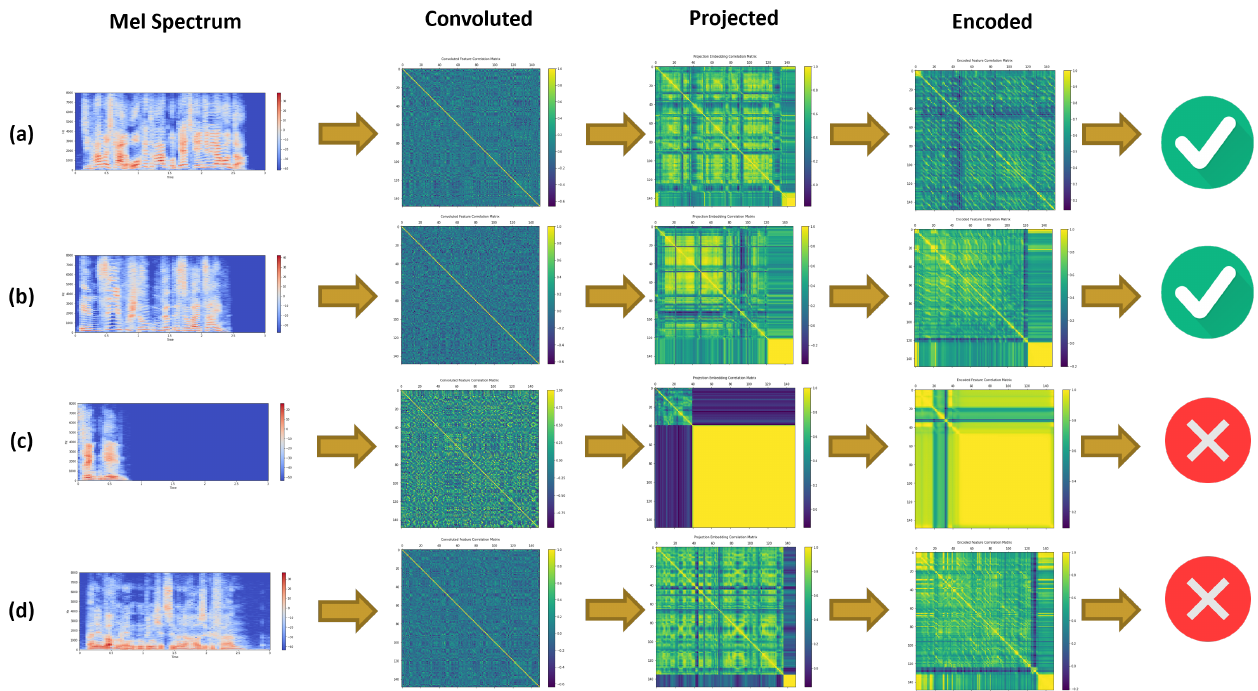
Figure 7. Correlation coefficients of E2ESER-CD using transfer learning of Wav2Vec2 with the CTR back-end network based on the Emo-DB dataset: ( a ) normal speech chunk, ( b ) chunk containing normal silence, ( c ) chunk containing mostly silence, and ( d ) chunk between speech. Note that the correct (green circle) and incorrect (red circle) signs are model results when compared with emotion labels. Please see the full resolution image in the supplementary